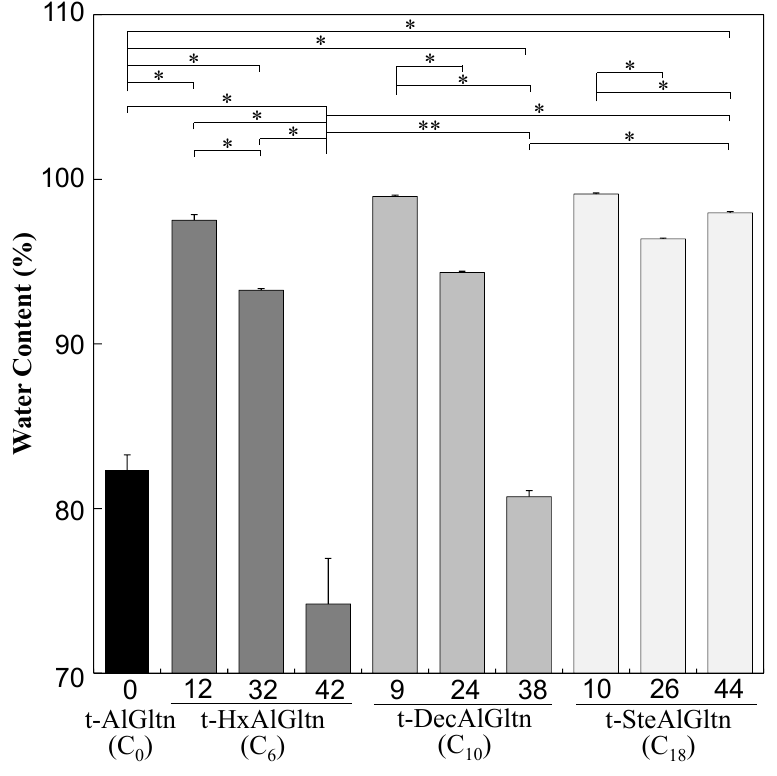
Figure 2. Water content of t-hm-AlGltn films after immersion in water at 37 °C for 5 min. Data are shown as the average ± S.D. of three samples (* p < 0.05, ** p ≥